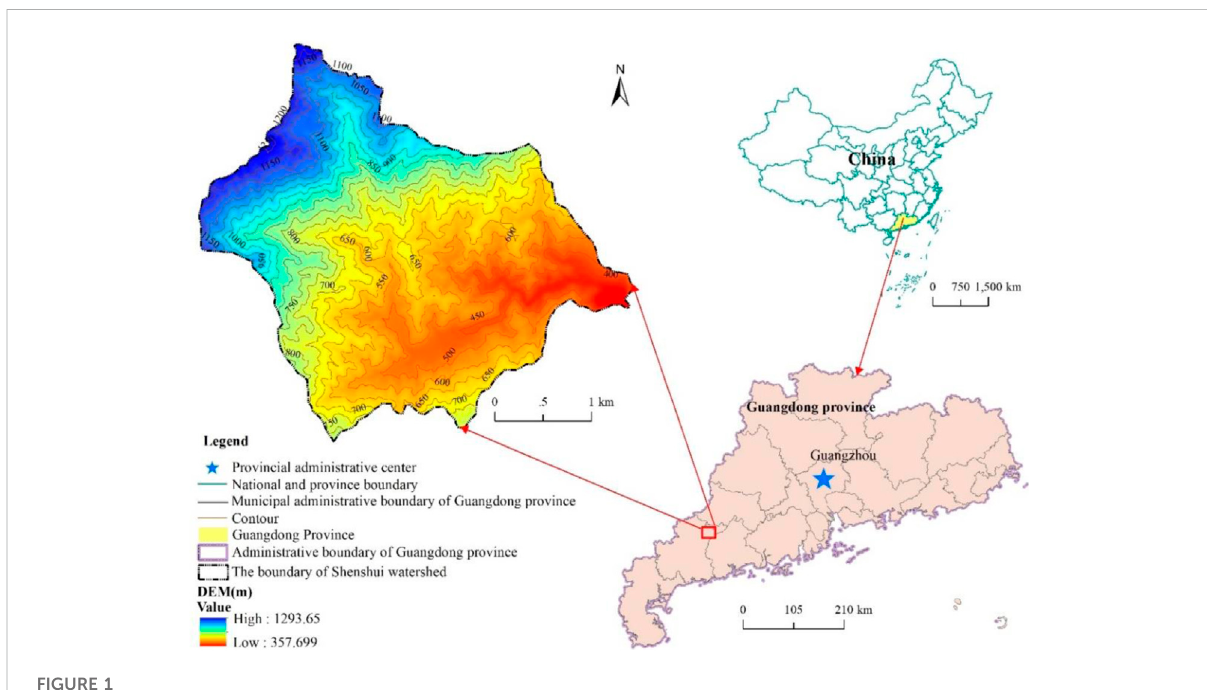
FIGURE 1 Location of the study